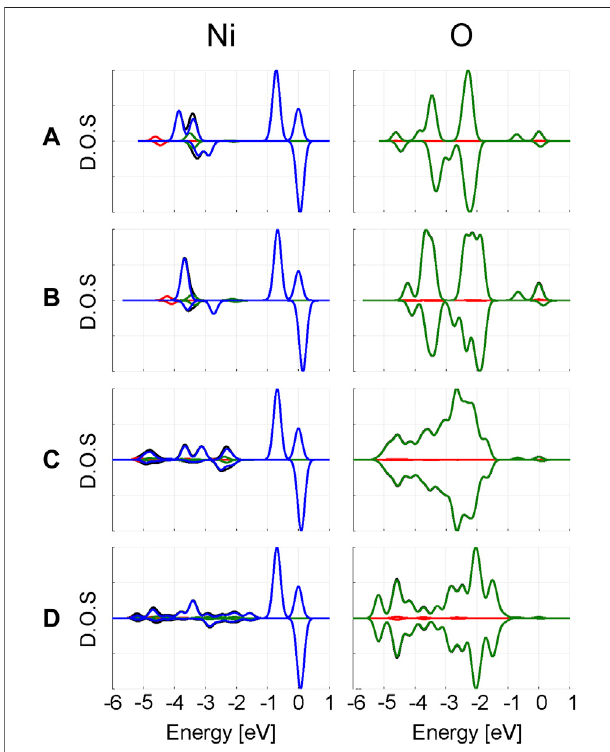
FIGURE 4 | Projected density of states from clusters (A) [ MgO 6 ] 10 − , (B) [ MgO ] 26 + , (C) [ MgO ] 50 − and (D) periodic PBE calculations 6 Mg 18 6 Mg 18 O 38 on Ni : MgO . The α spin channels are plotted with positive amplitudes and β spin channels with negative amplitudes. The Fermi level of the α spin channel is set as zero. D.O.S stands for density of states and is given in arbitrary units. The colour scheme of the PDOS is as follows: black — total, red — s, green — p and blue — d. The PDOS were obtained via Gaussian smearing of the canonical molecular orbital energies, using a smearing width of 1 meV.